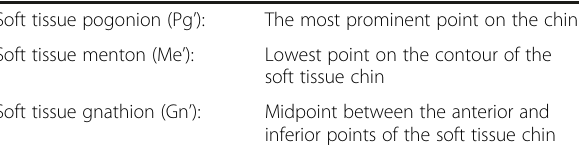
Table 1 Description of cephalometric landmarks used in this study